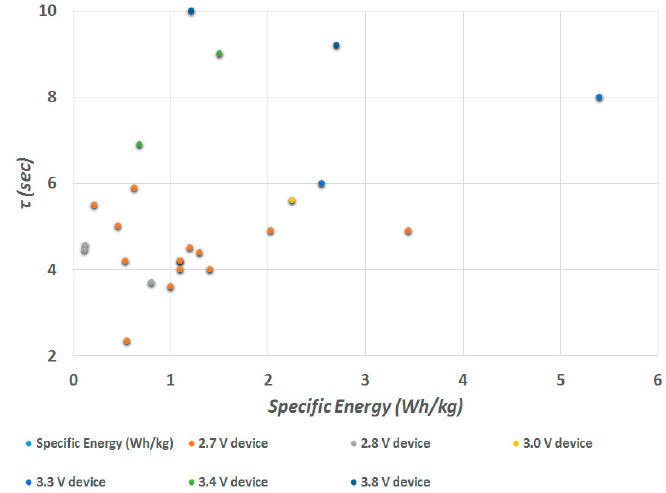
Figure 5. Tau increasing with specific energy.